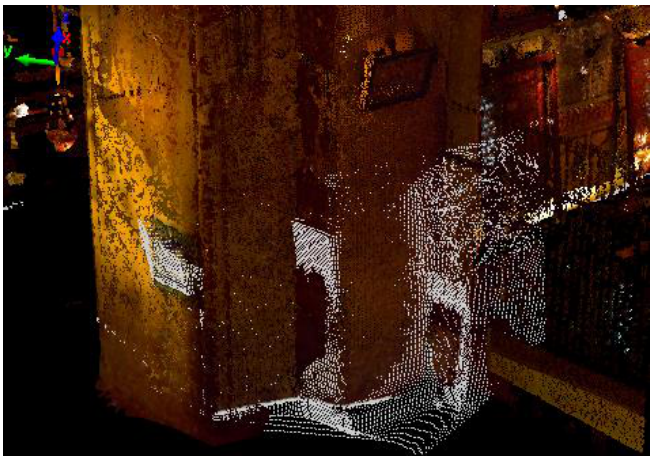
Figure 10. The point clouds of the ToF camera and TLS were combined with ICP.